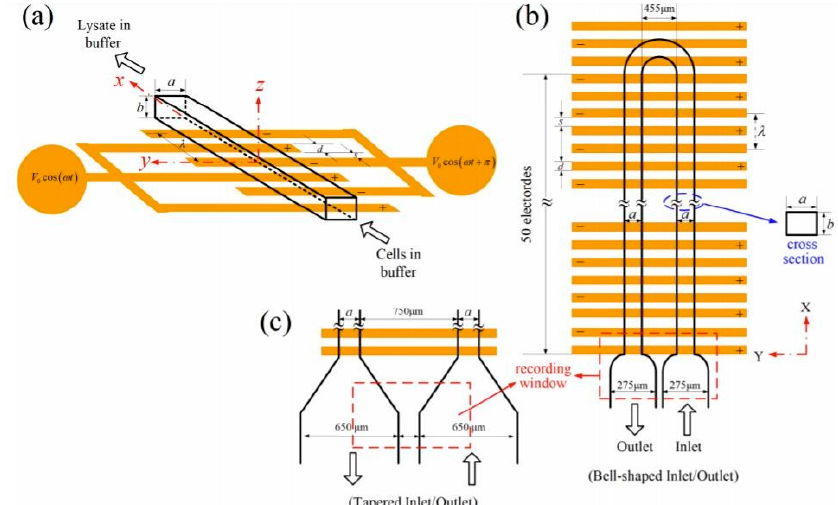
Figure 17. ( a ) Sketch of a simple flow-through device for continuous electrical lysis of cells utilized in [67]. ( b ) Top view of the device. ( c ) An alternative inlet/outlet design for reducing the flow in comparison with that in ( b ), for a clear observation of cell lysis utilized in [67]. Cells in the region between the salt bridges experience an electric field.